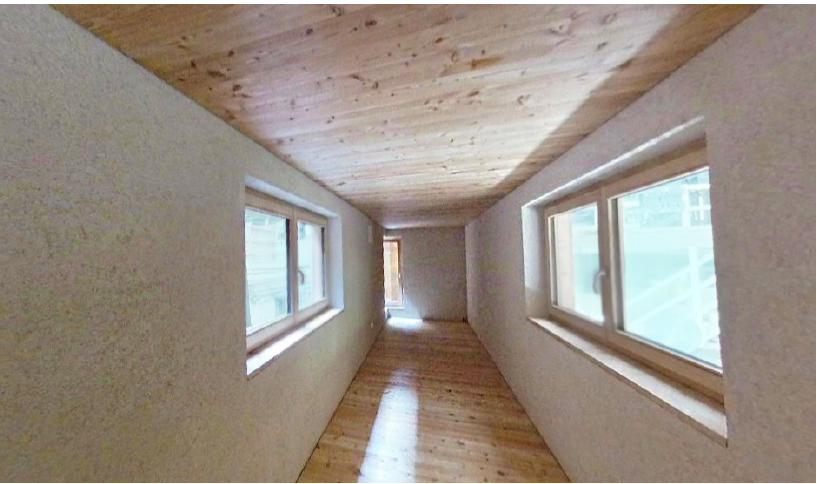
Figure 3. The Tiny FOP MOB prototype (interior view).